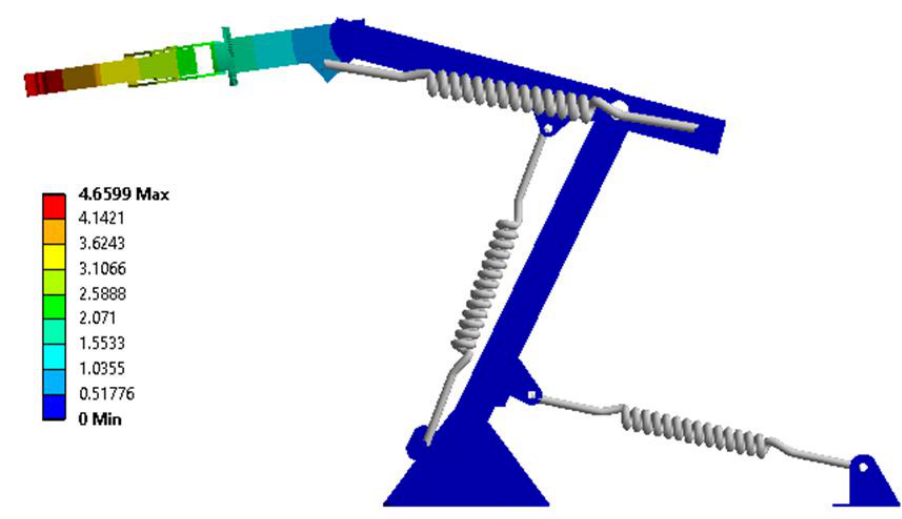
Figure 14. The resulting displacement field for configuration 1 and a force of 15 N.